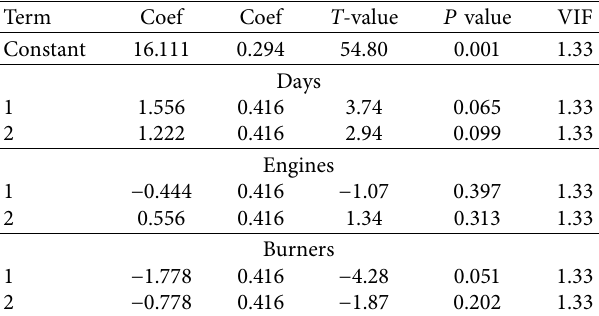
Table 7: Coefcients of